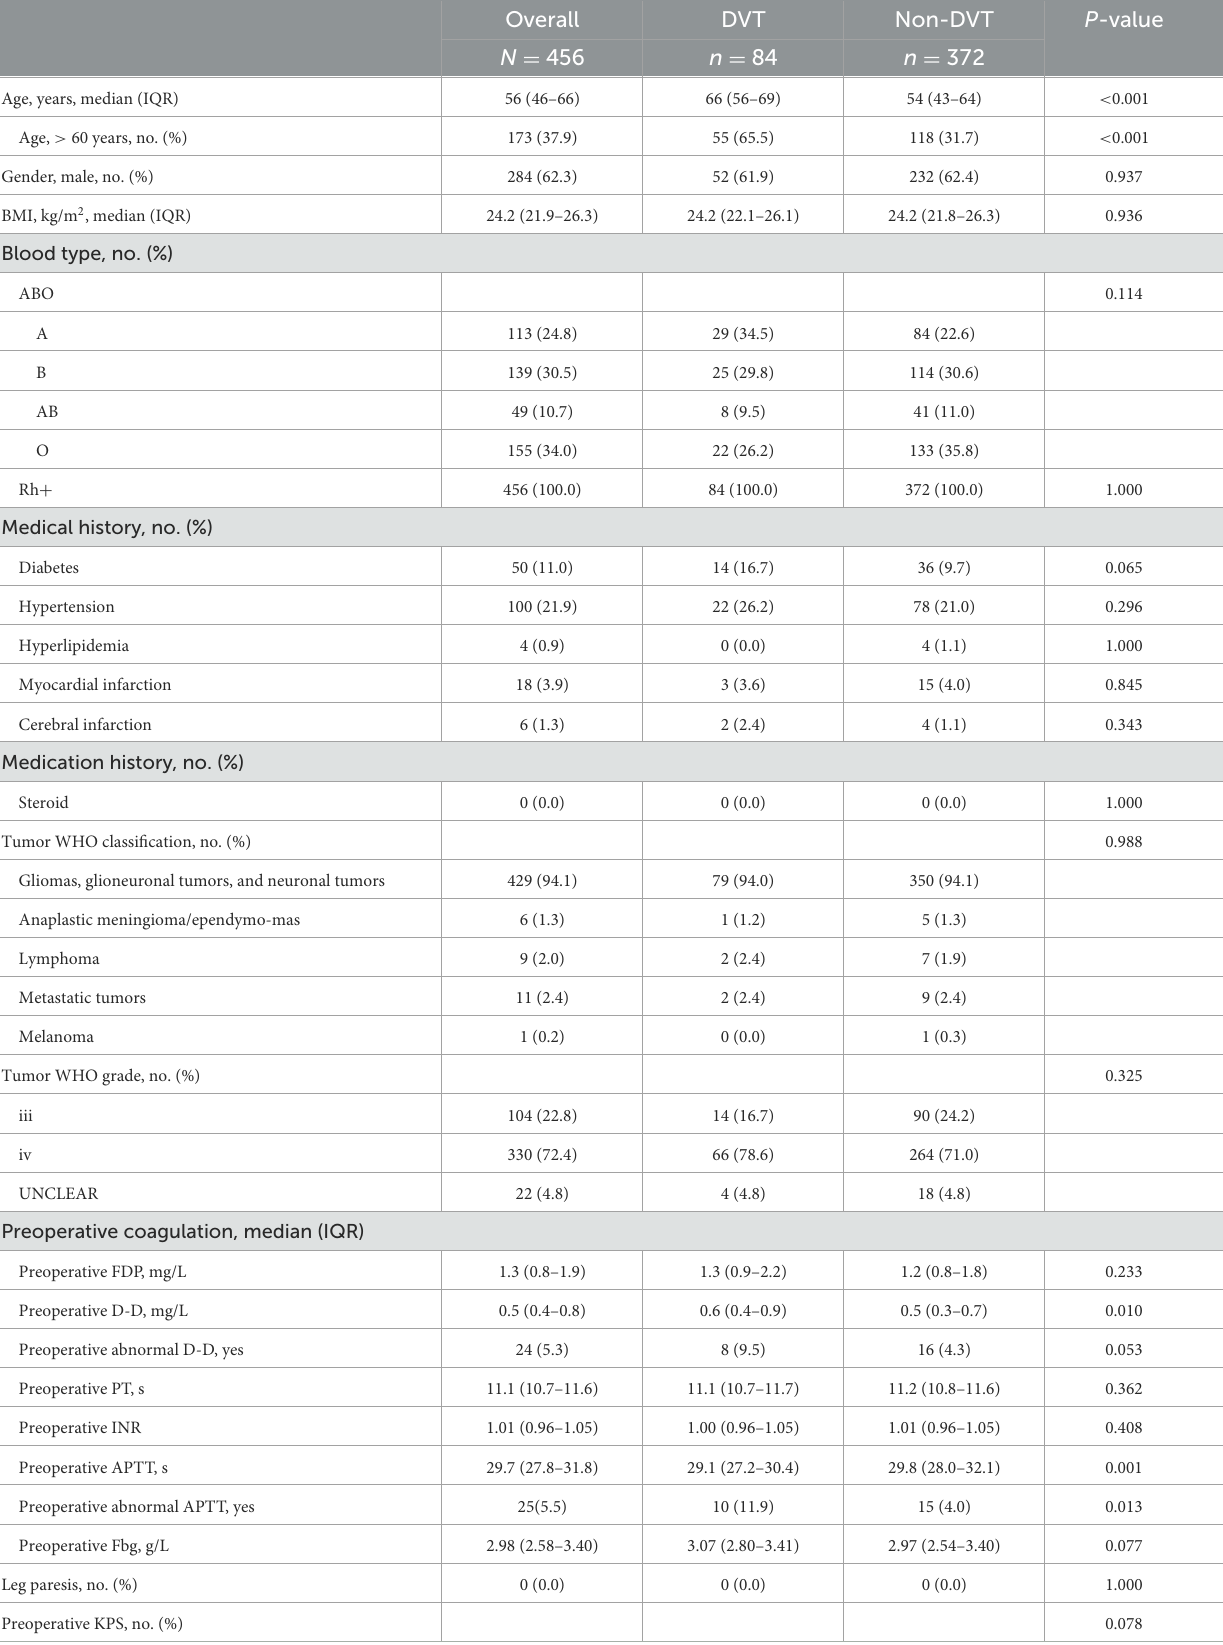
TABLE 2 Demographics, baseline values, and perioperative variables group by deep venous